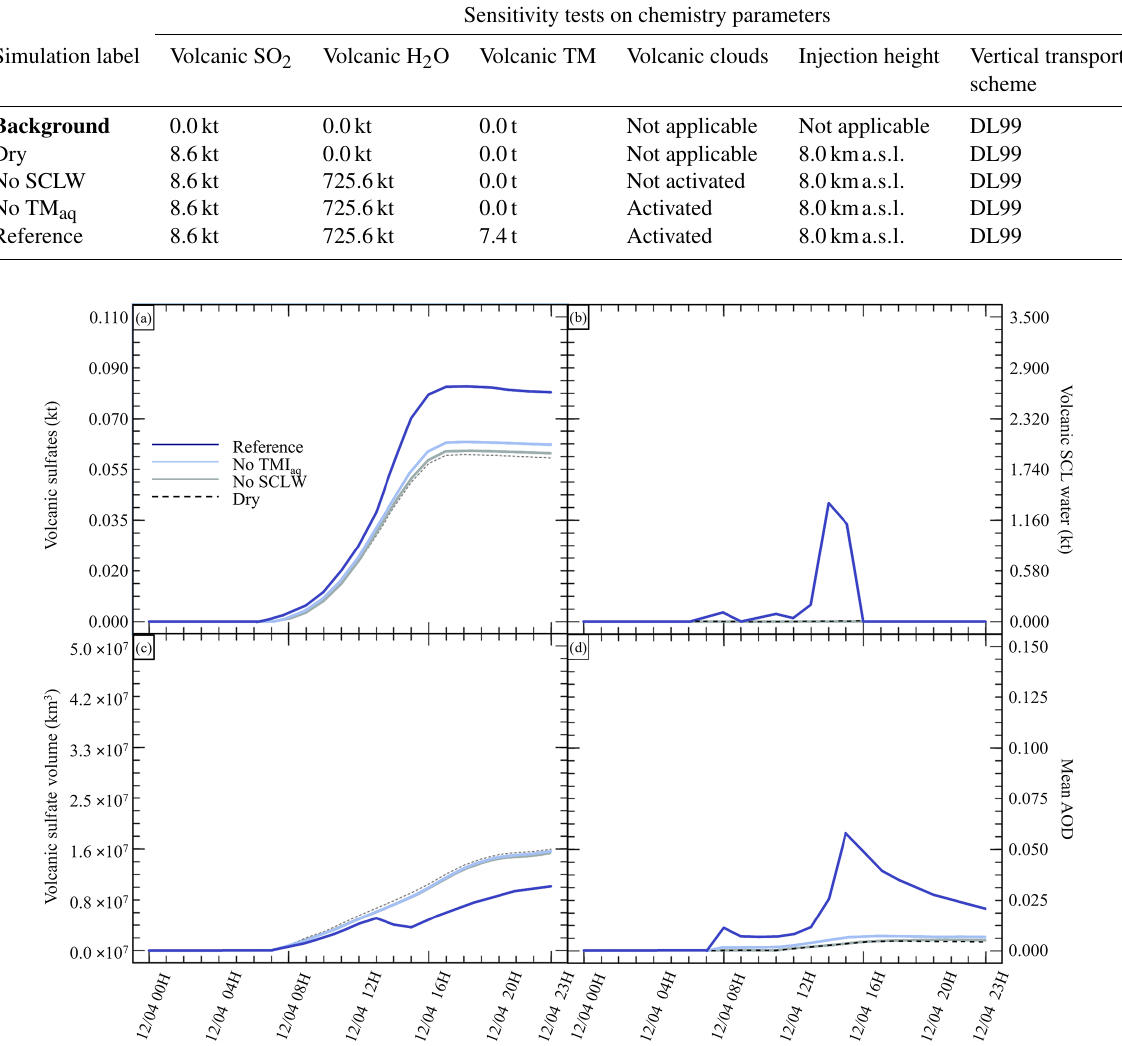
− , kt), (b) supercooled liquid water (kt), (c) the minimum 4(p) mass. The Reference simulation is the closest to a 4(p)